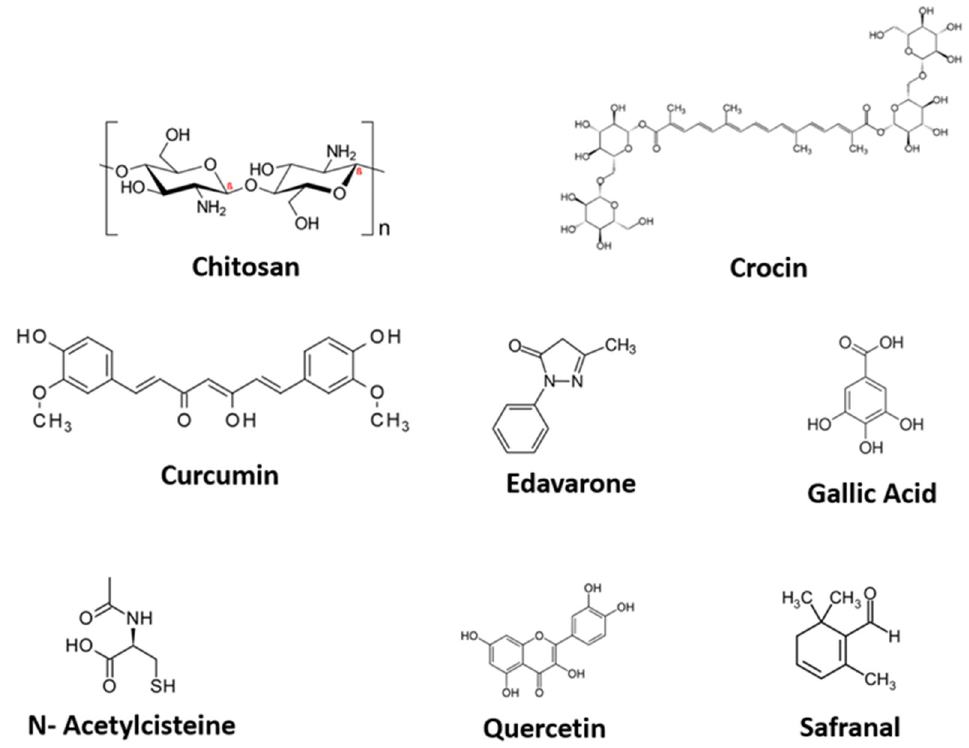
Figure 2. Chemical formula of the antioxidant substances. Table 1. Compounds with antioxidant